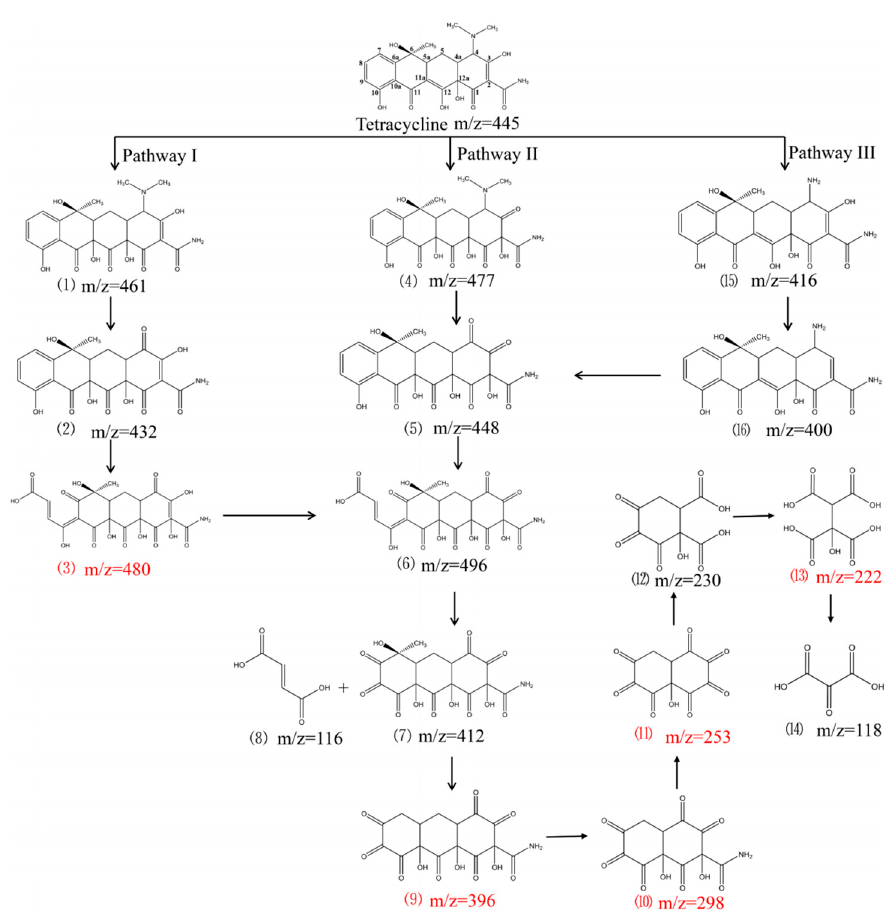
Figure 6. Proposed degradation pathway of tetracycline after electrocatalytic oxidation by D-UiO- 66/Graphite /PVDF anodic membrane. The speculated intermediate is presented in red font [148]. The cost of membrane cleaning is significantly related to the cleaning agent, cleaning method and membrane pollution degree. The thickness of the filter cake layer shows a “V” trend with increasing amount of flocculating agent. Warm water is usually used to